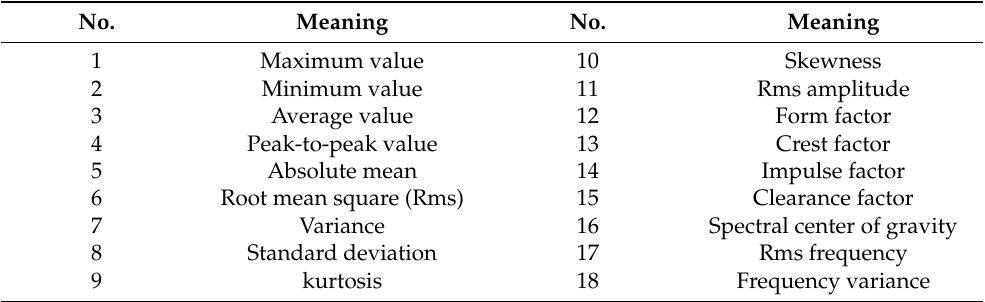
Table 1. Feature meaning. No. Meaning No.